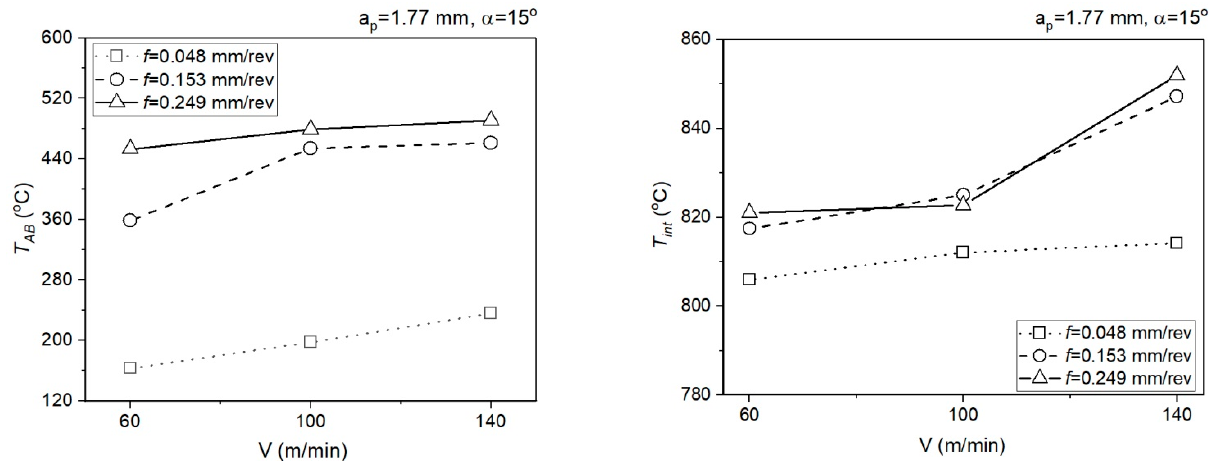
Figure 11. Impact of the cutting data on the mean temperature in the PSZ and SSZ, a p = 1.77 mm, α = 15°. The mean temperature values in the PSZ obtained using the analytical method and the results of measurements with a thermovision camera during the laboratory tests are presented below in Figure 12.